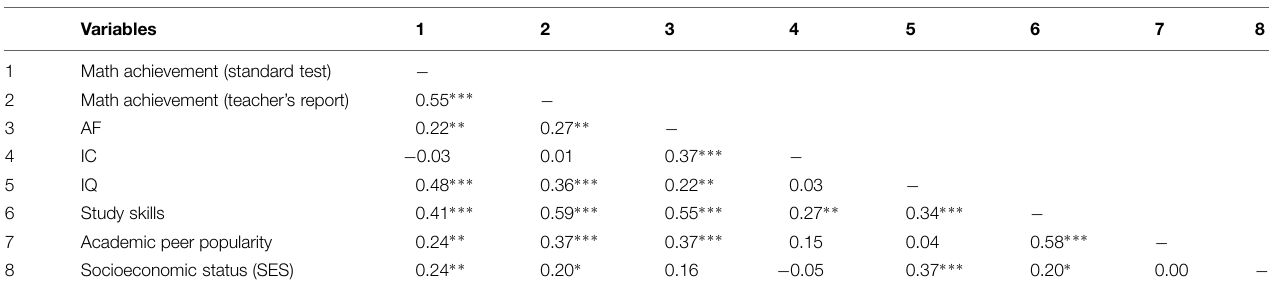
TABLE 2 | Zero-Order correlations for the study